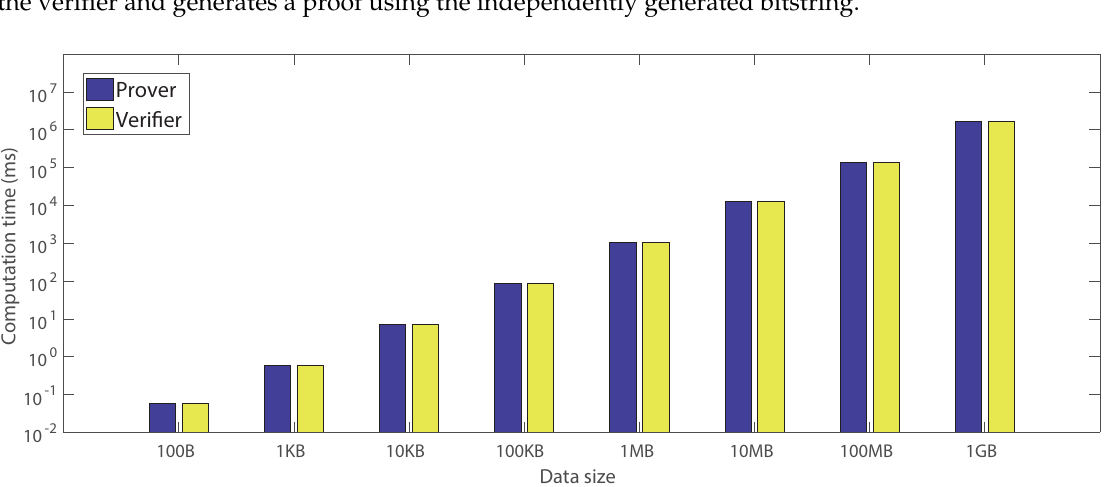
Figure 6. Computation time for hardcore function-based